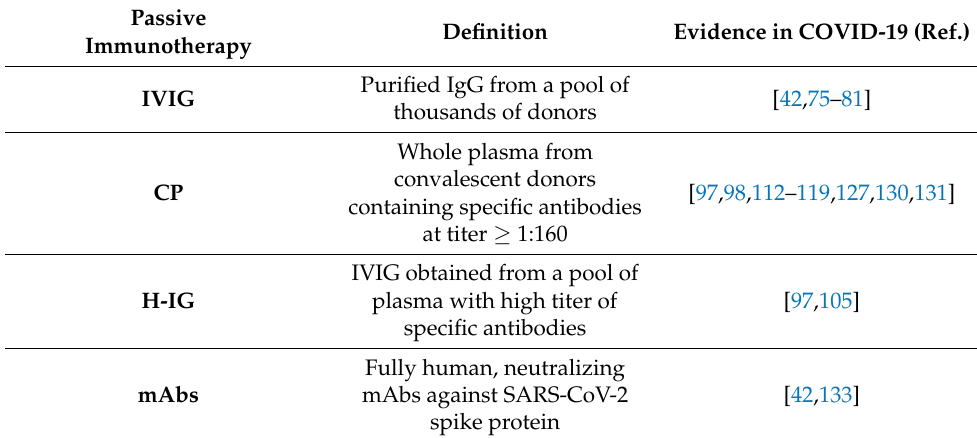
Table 2. Passive immunotherapy in COVID-19.